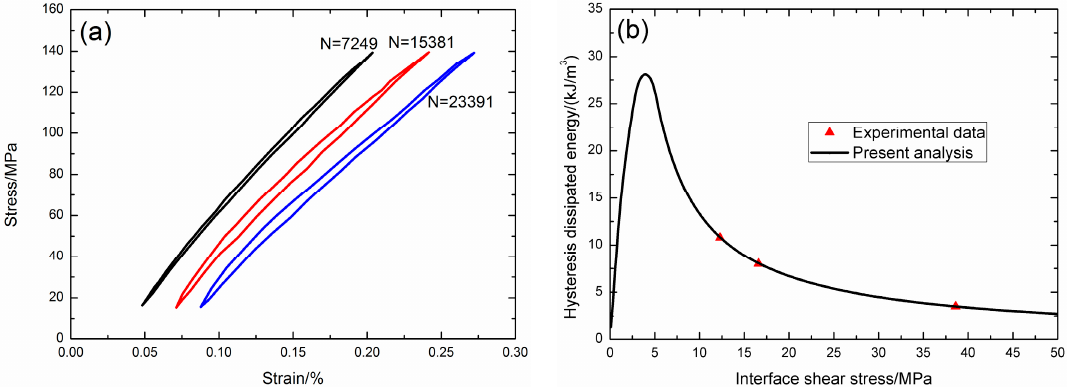
Figure 16. ( a ) The experimental fatigue hysteresis loops corresponding to different cycle number; and ( b ) the experimental and theoretical fatigue hysteresis dissipated energy versus interface shear stress curve of 2D woven SiC/SiC composite under σ max = 140 MPa at 1100 °C in air. Table 11. The interface shear stress of 2D woven SiC/SiC composite corresponding to different applied cycles under fatigue peak stress of σ max = 140 MPa at 1100 °C in air.